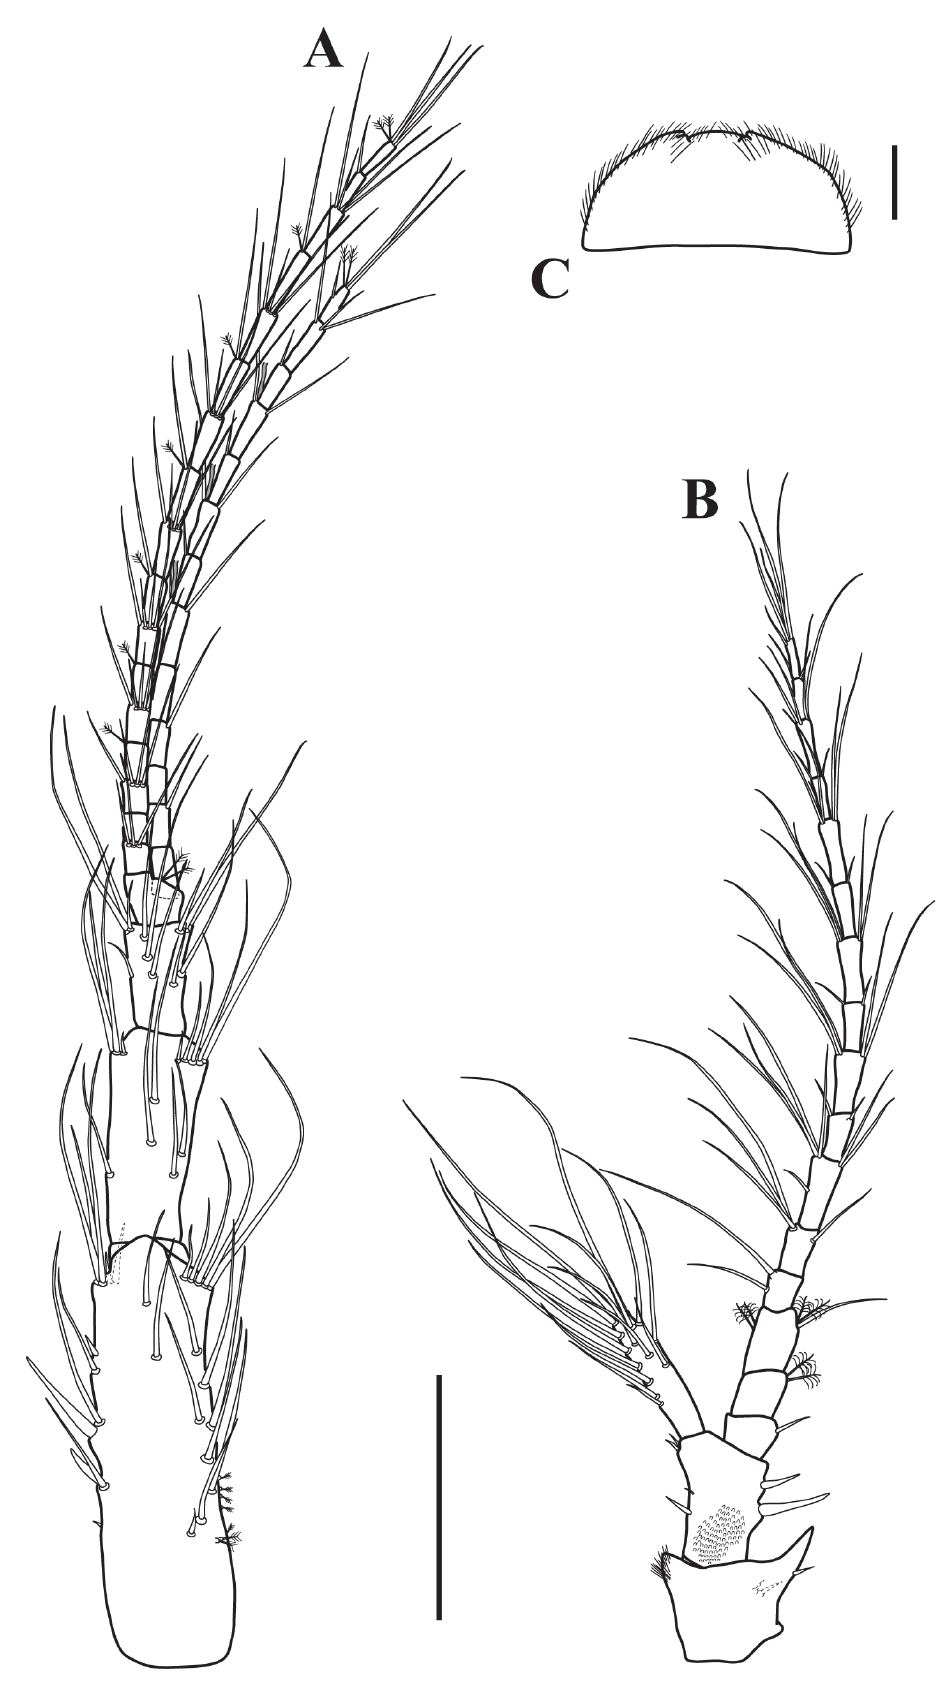
Figure 3. Brachylicoa lui sp. n. holotype female with oostegites and genital cone. A antennule; B antenna; C labrum. Scale bars = 0.5 mm for A − B and 0.1 mm for C